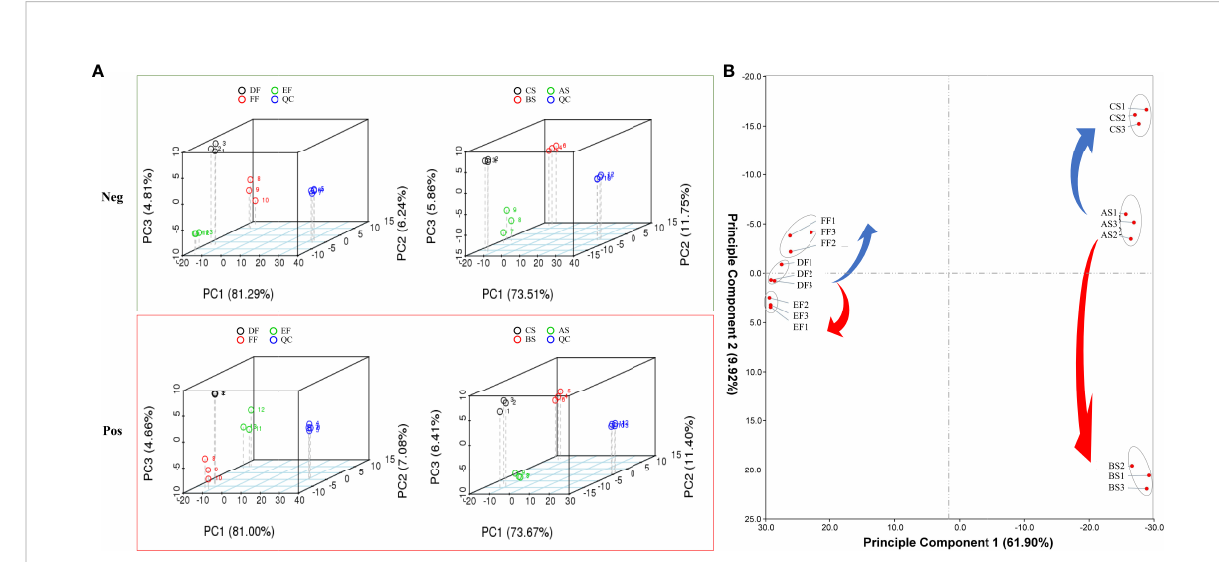
FIGURE 4 PCA for the metabolites in extracted fractions analyzed by LC-ESI-ion trap MS/MS. (A) PCA analysis in negative and positive ion modes. Quality Control (QC) was an equivalent standard, which is used to evaluate the stability and signal response strength of the instrument during metabolite detection. (B) PCA scatter plot of samples dehydrated under different temperature based on their metabolic data. The samples in the same dehydration stage were wrapped by gray solid circles. Samples were divided into two groups including seeds (RT (AS), heat (BS), and cold storage (CS)) and fruits (RT (DF), heat (EF), and cold storage